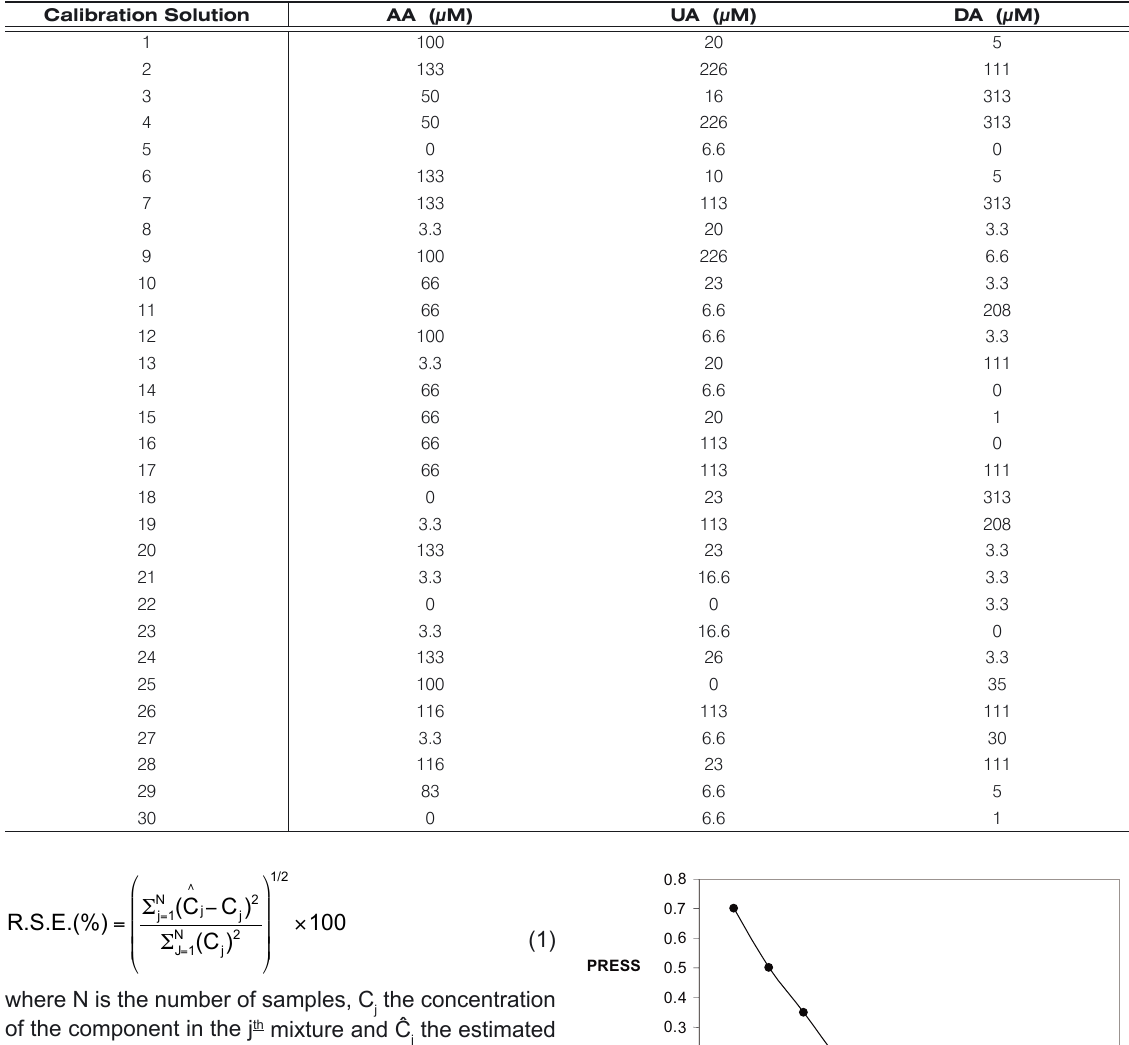
Table 2. Calibration solution composition.